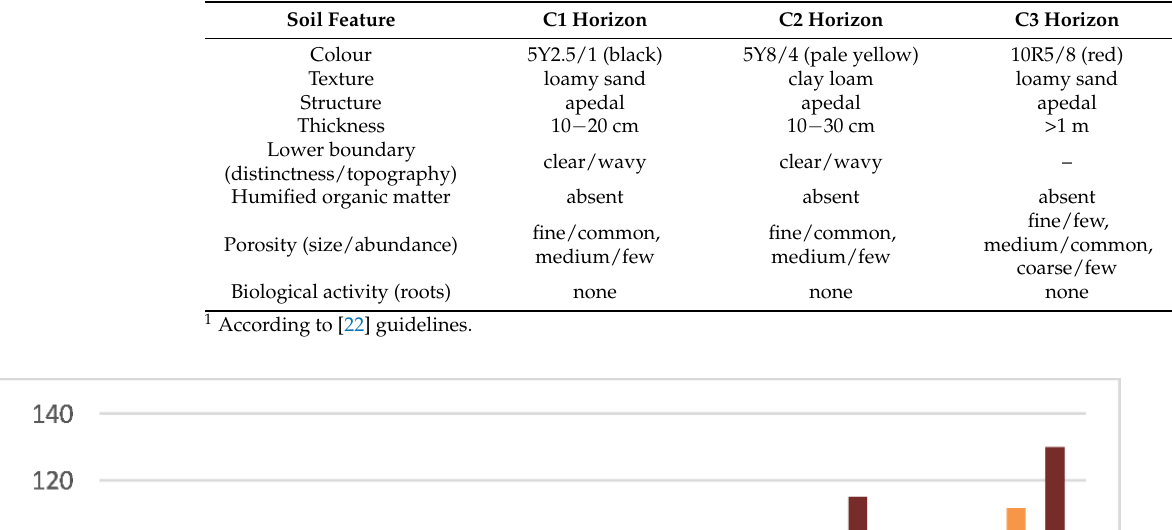
Table 2. Soil Characteristics in the Coal Mine waste Pile Affected by Self-burning 1 .